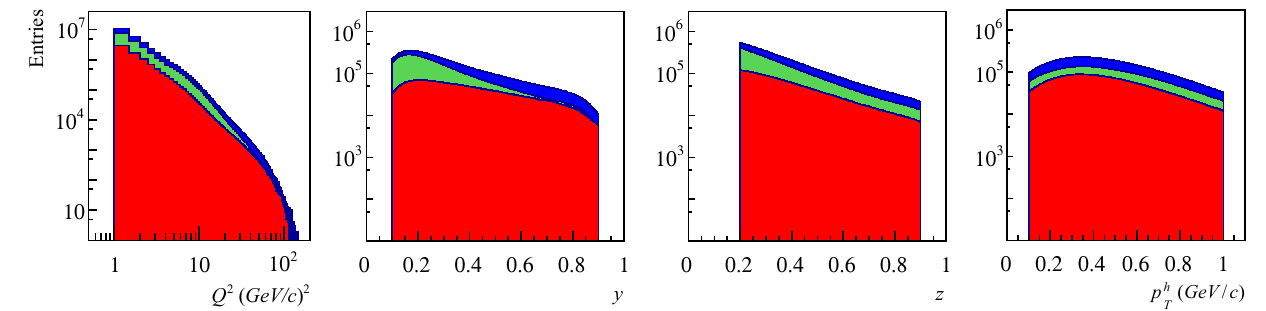
within the region shown in Table 1: T